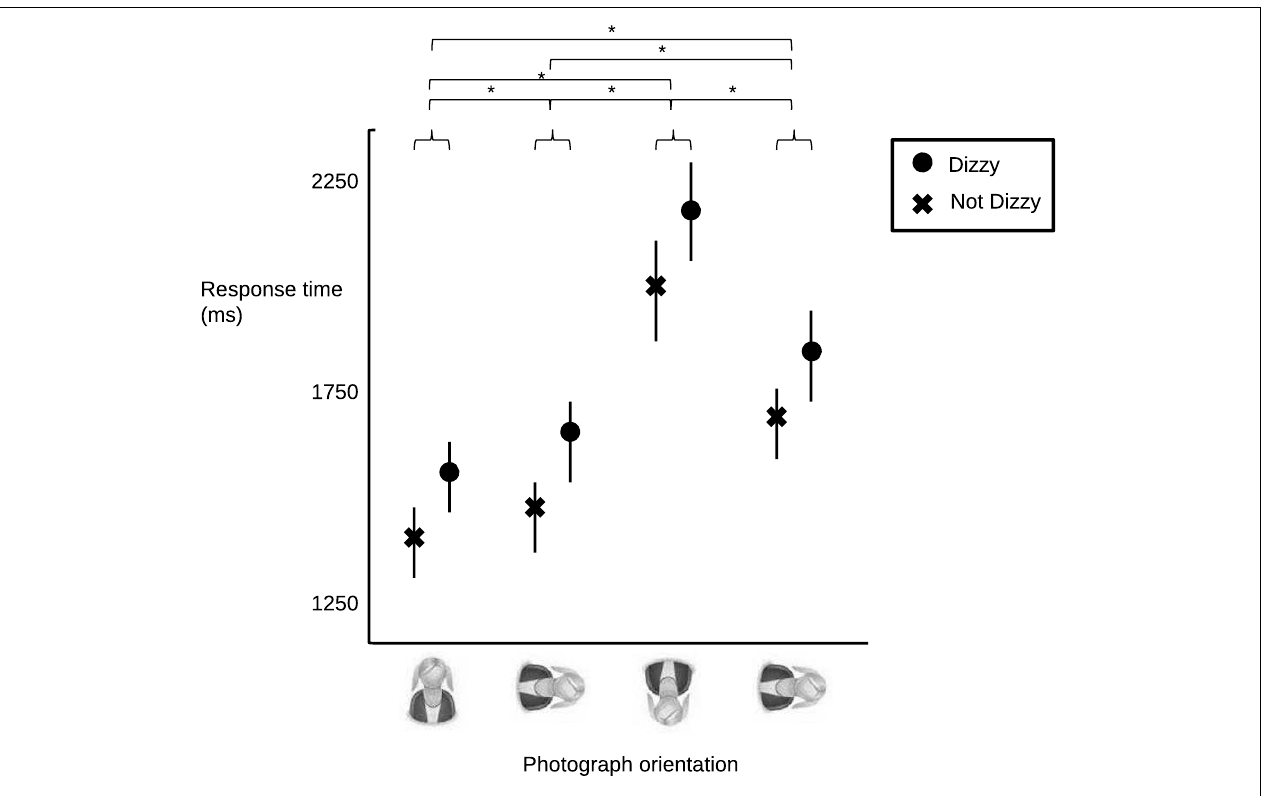
FIGURE 2 | Mean (circles and crosses) and 95% confidence intervals (lines) for response times for the “dizzy” group (circles) and control group (crosses) at the four image orientations .There was no Group × task interaction, but there was an effect of orientation. Asterisk (*) denotes significant at p <